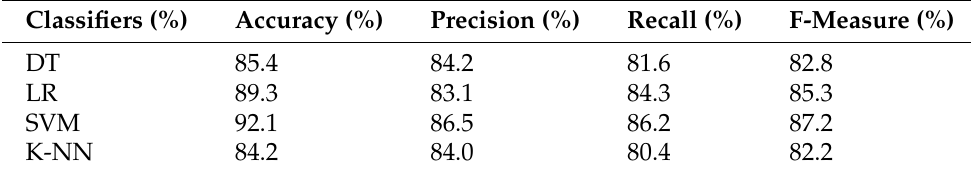
Table 10. Performance evaluation based on reduced set of features using different classification